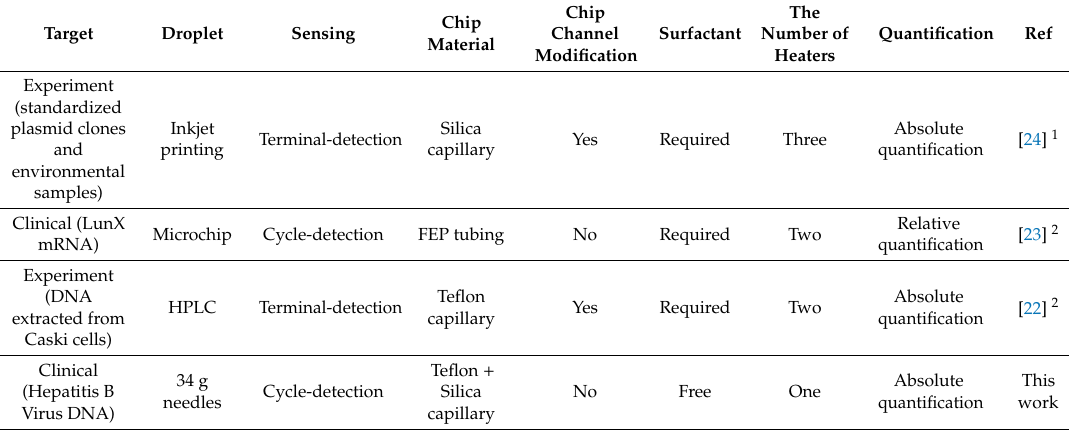
Table 1. Comparison of the four droplet